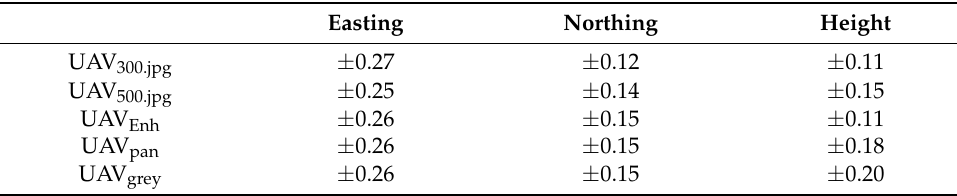
Table 4. Root Mean Square Error (RMSE) Results (meters). Easting Northing